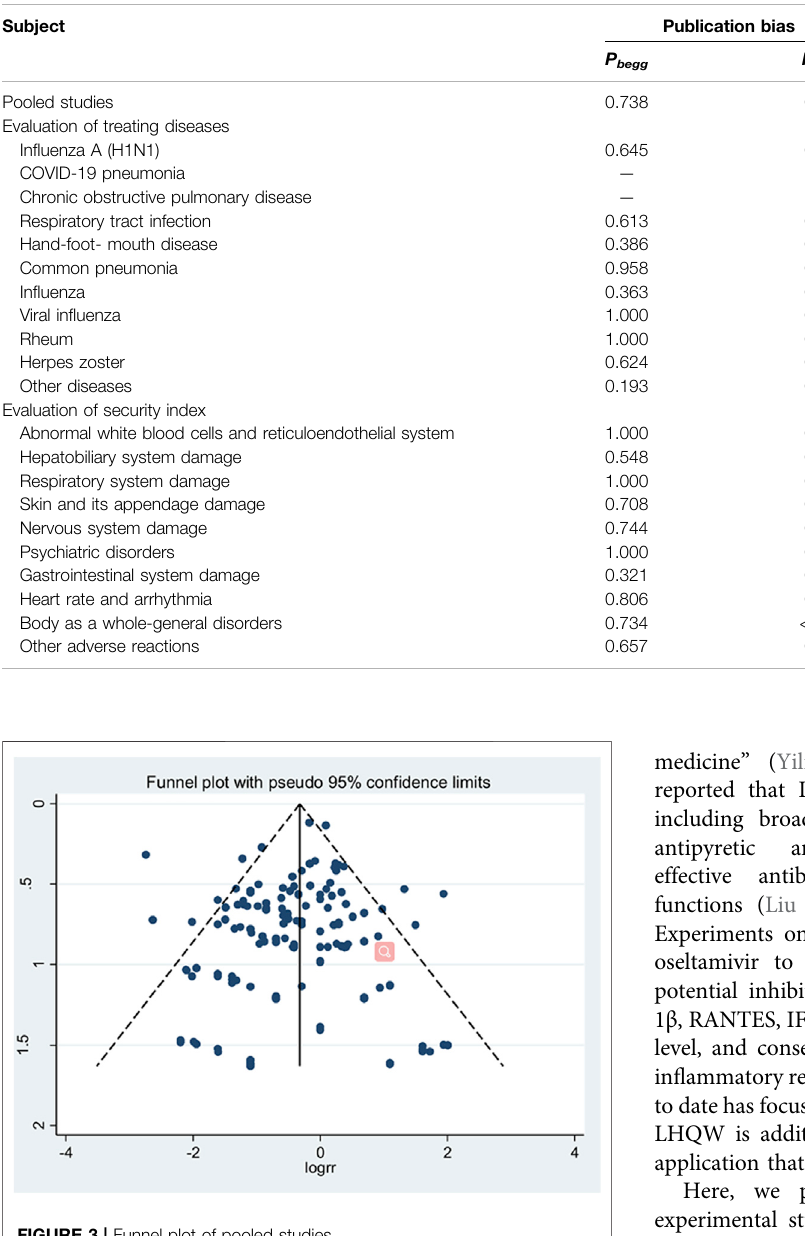
FIGURE 3 | Funnel plot of pooled